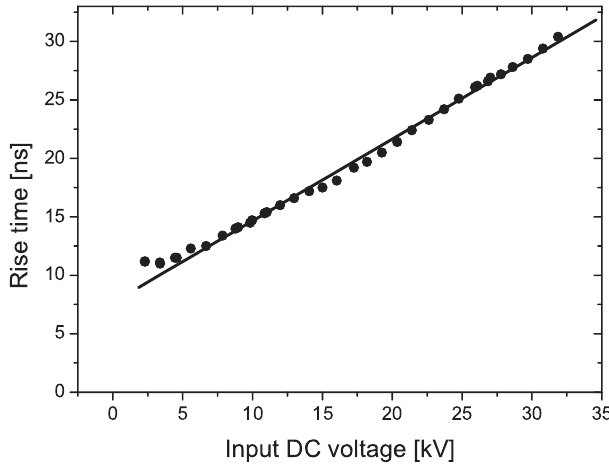
FIG. 8. High voltage pulse rise time at different input DC voltages.